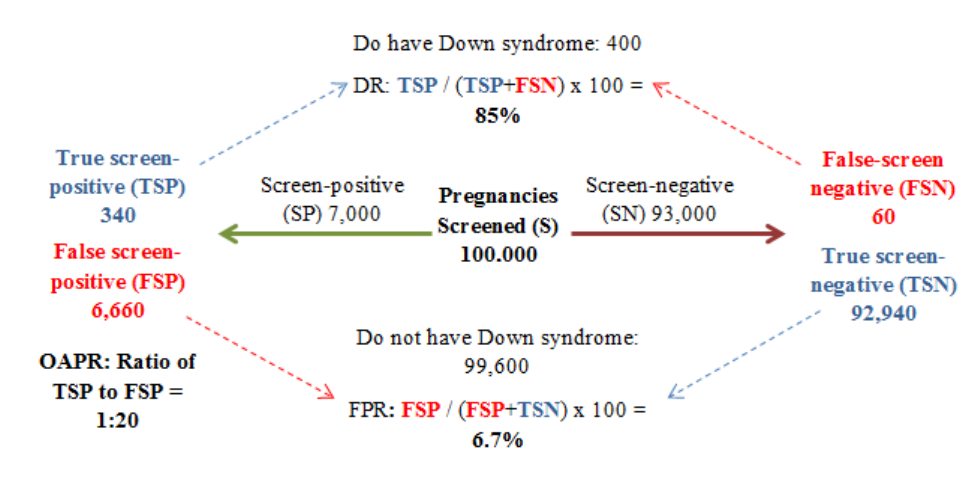
Figure 2. The screening process, potential outcomes and measures of accuracy. Detection rate (DR): Proportion of affected cases successfully identified by the screening test. TSP/(TSP + FSN) = 85%. False positive rate (FPR): Proportion of positive results in non-affected cases identified by the screening test. FSP/(FSP + TSN) = 6.7% (adapted from